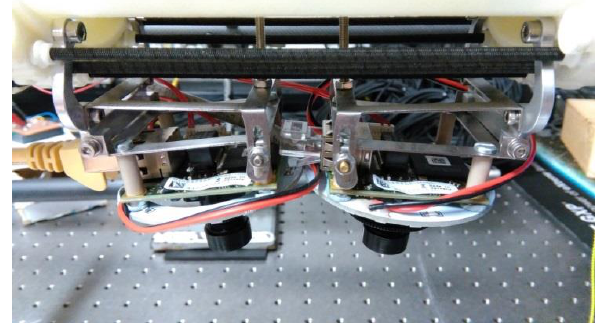
Figure 3. Stereo-Camera mountings